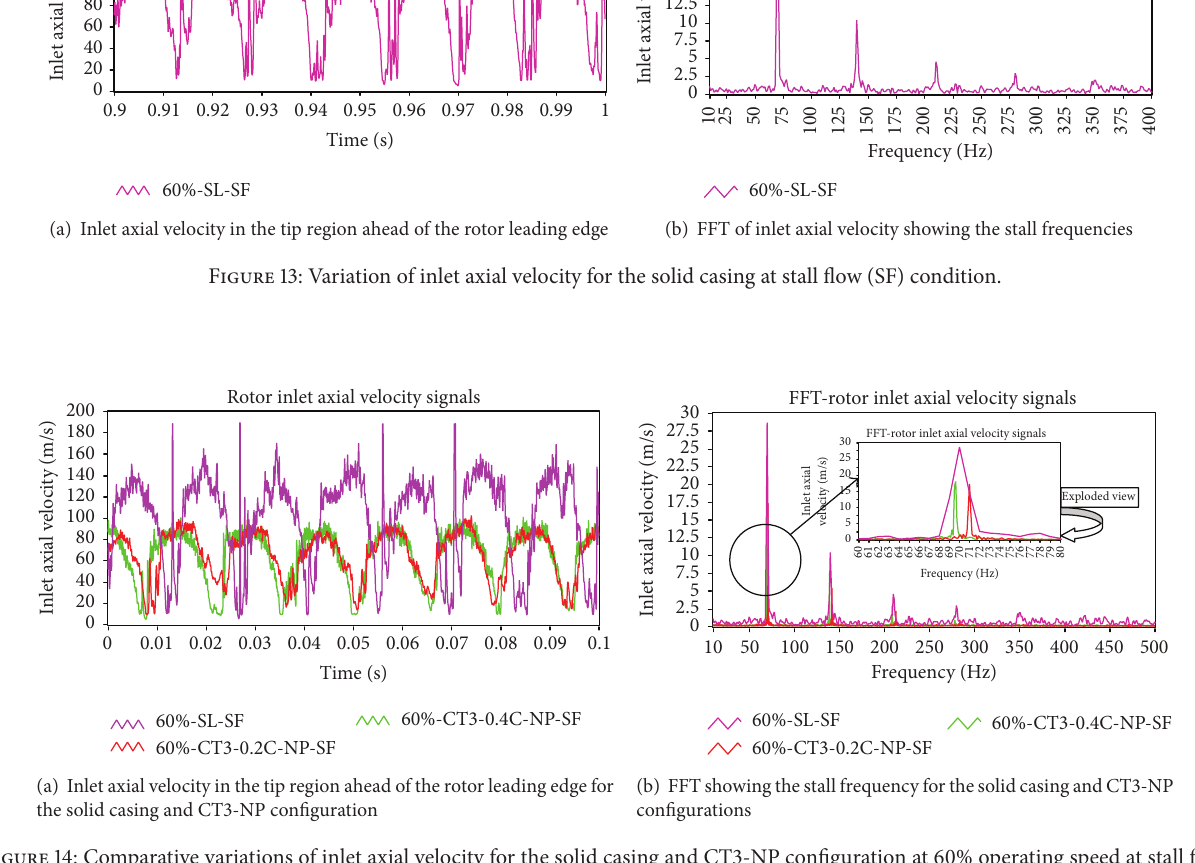
Figure 14: Comparative variations of inlet axial velocity for the solid casing and CT3-NP configuration at 60% operating speed at stall flow (SF) condition for 20% and 40% axial coverage.